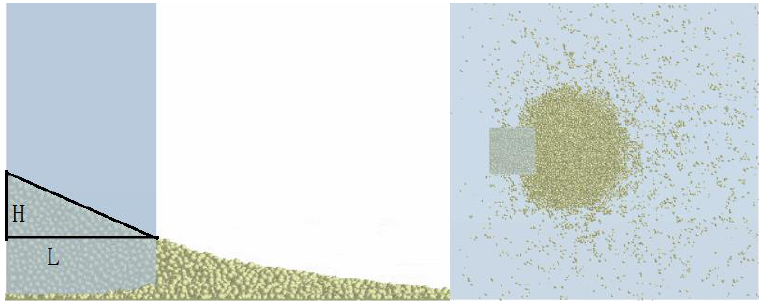
Figure 8. One simulation result of the angle of repose. Table 5. Simulation results.